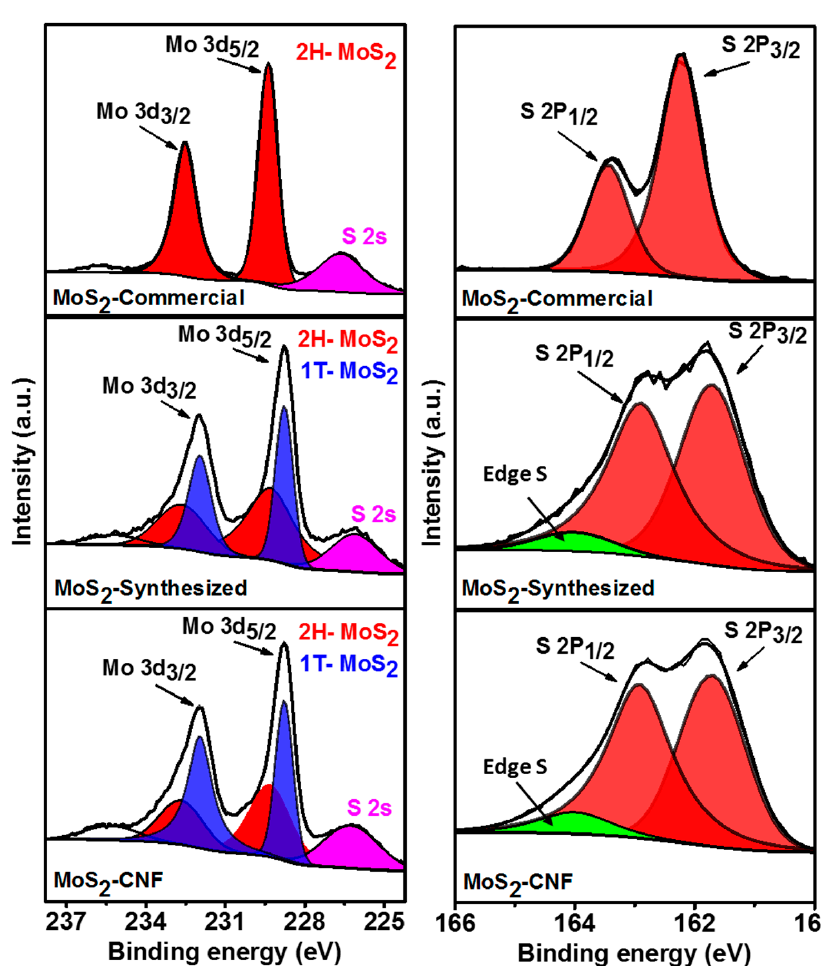
Figure 2. X-ray photoelectron spectroscopy (XPS) spectra of Mo 3d and S 2p for MoS 2 -Commercial, MoS 2 -Synthesized, and MoS 2 -CNFs.